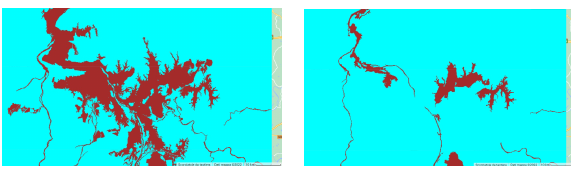
Figure 13. Water detection image on April-June 2022 (left) and on July-September 2022 (right).